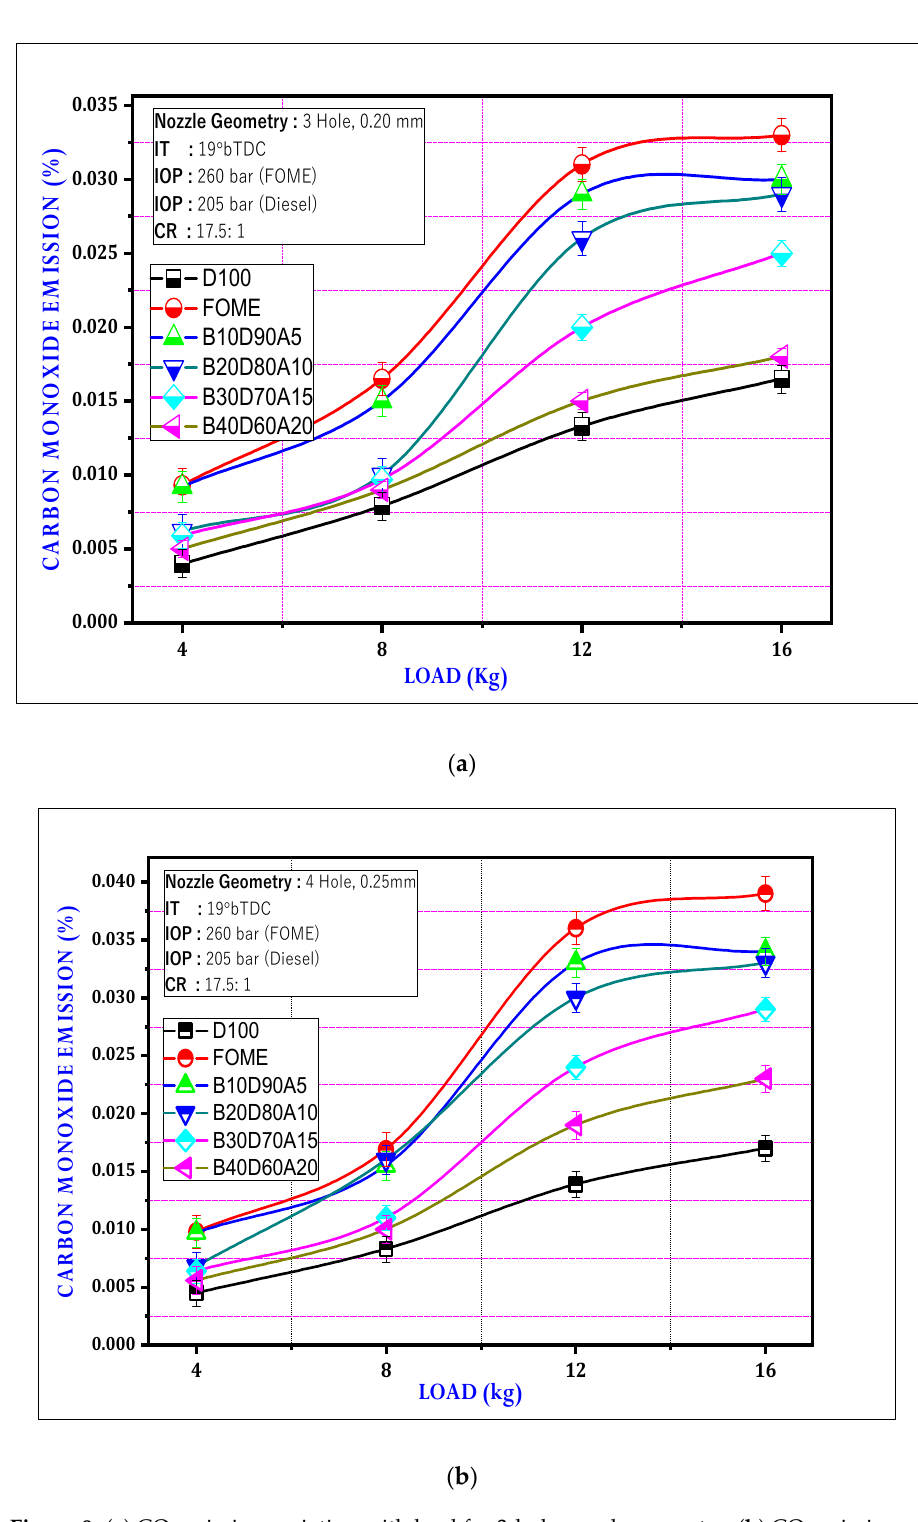
Figure 9. ( a ) CO emission variation with load for 3-hole nozzle geometry. ( b ) CO emission varia- tion with load for 4-hole nozzle